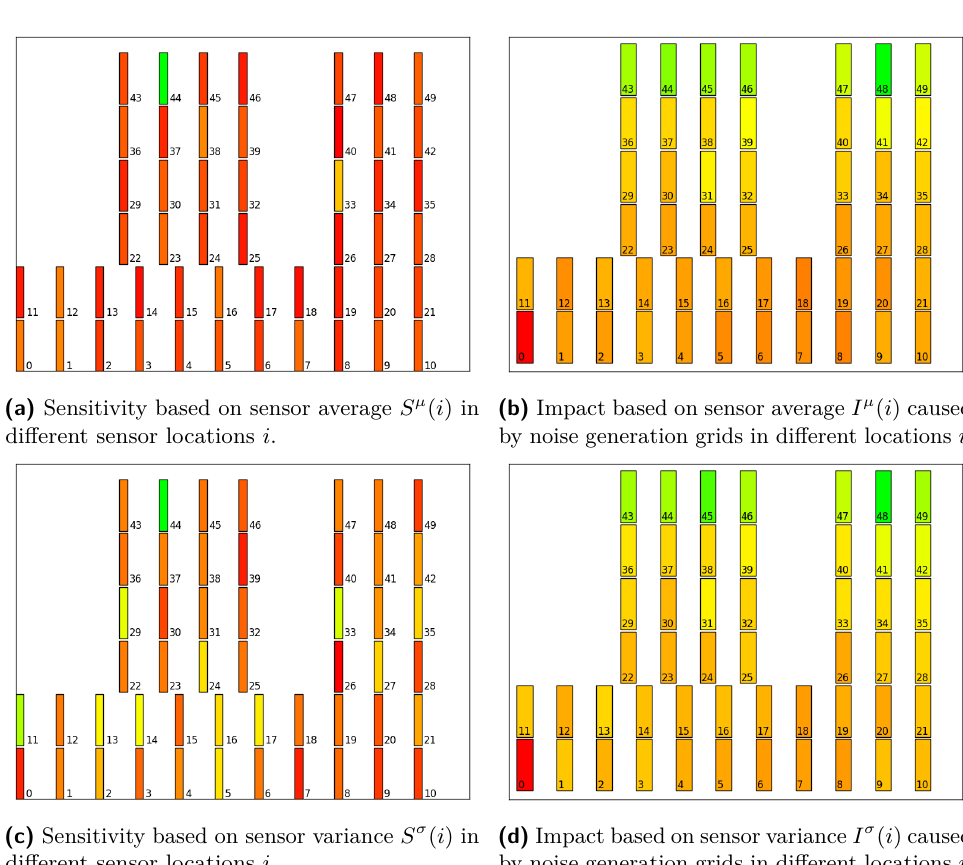
Figure 14: Influence of global placement of FF-based noise generators and TDC sensors evaluated and averaged over 1000 measurements on board B. Locations that are colored orange/red correspond to sensors that are more sensitive or noise generators that cause a higher impact respectively. Green colored locations are less sensitive or cause less